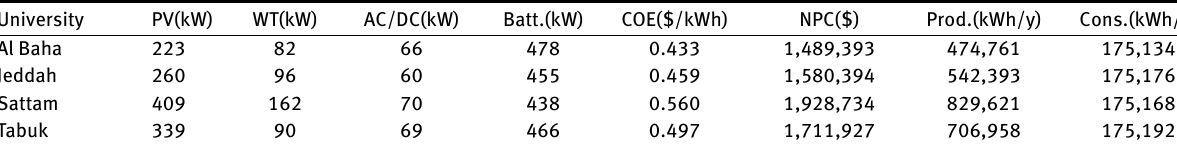
Table 9: Detailed environmental results for selected universities. Emissions (kg/year)